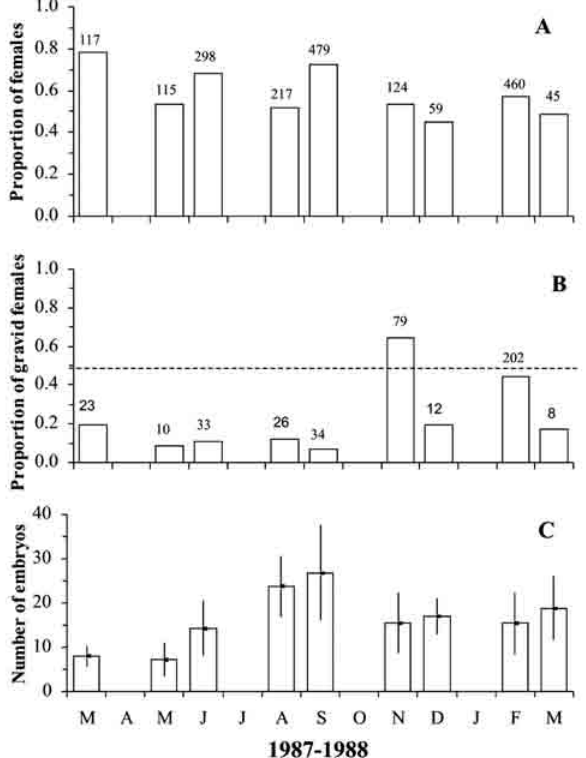
F IG . 5. – Annual variation of: (A) the sex-ratio, (B) the proportion of gravid females in the total females and (C) the mean number of embryos (± SD) per female of Neomysis americana . Figures on top of the bars in (A) and (B) indicate the number of observations.